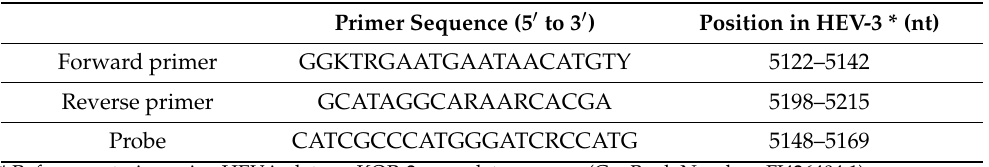
Table 1. Primer and probe set for quantification of the HEV genome. Primer Sequence (5 (cid:48) to 3 (cid:48) ) Position in HEV-3 * (nt) Forward